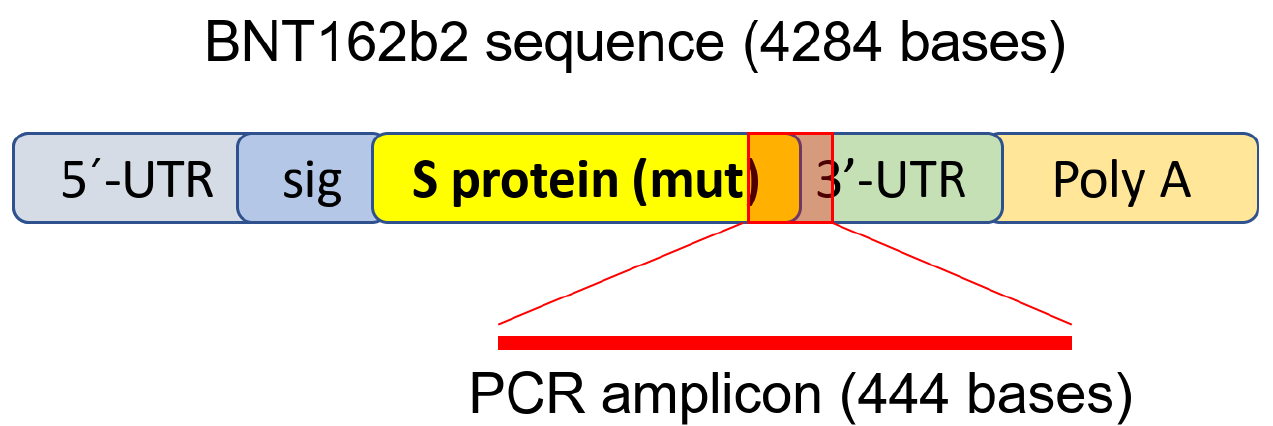
Figure 1. PCR primer set used to detect mRNA level and reverse-transcription of BNT162b2. Illustration of BNT162b2 was adapted from previously described literature [34].